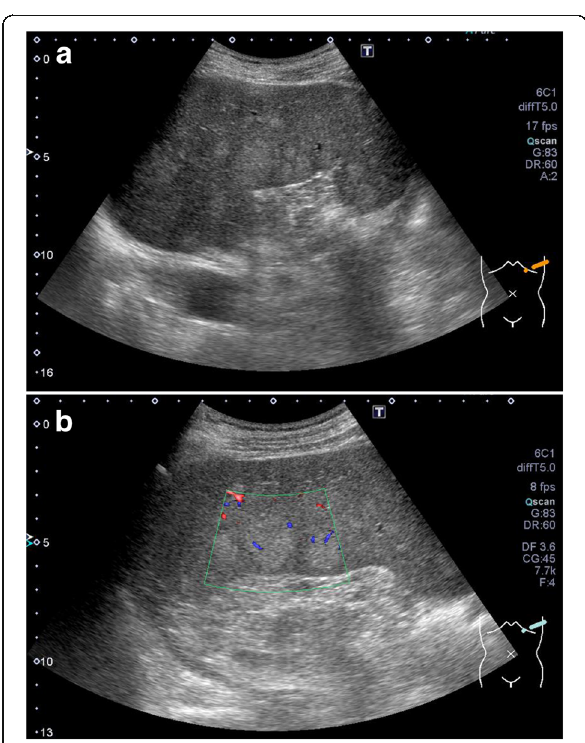
Fig. 1 a Abdominal ultrasonography findings. Multiple round hyperechoic nodules are seen. b Doppler ultrasonography findings. Uneven blood flow is observed in the